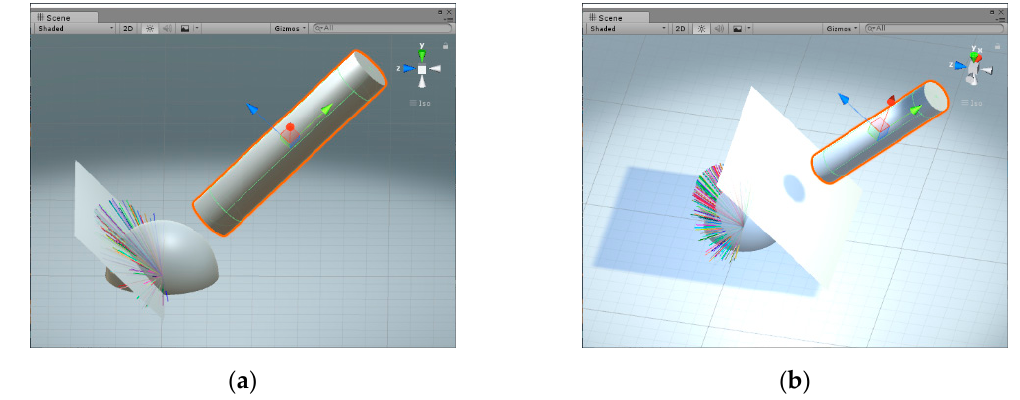
Figure 2. The Hough transform process: ( a ) 3D transform for the direction; ( b ) 2D transform for the diameter.